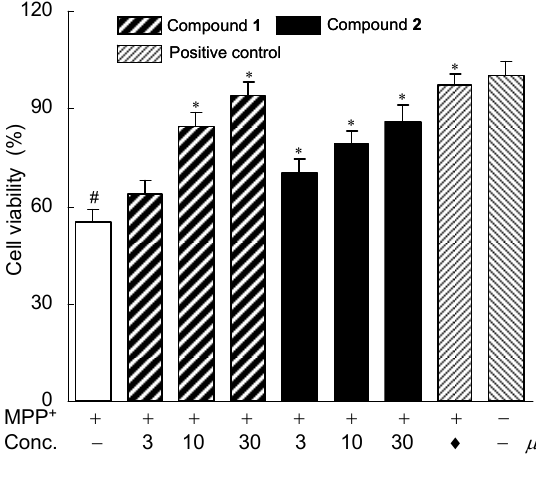
Figure 3. Neuroprotective effects of compounds 1 and 2 . The SH-SY5Y cells were exposed to MPP + and the cell viability was assessed by MTT assay. The cells were treated with 0.8 mM MPP + in the absence or presence of compounds 1 and 2 . Data are expressed as the percentage of values in untreated control cultures. Each value indicates a mean ± SEM (n = 3). # p < 0.05, compared with control group. * p < 0.05, compared with the MPP + -treated group.  Indicated positive control, bakkenolide H, 15 μ